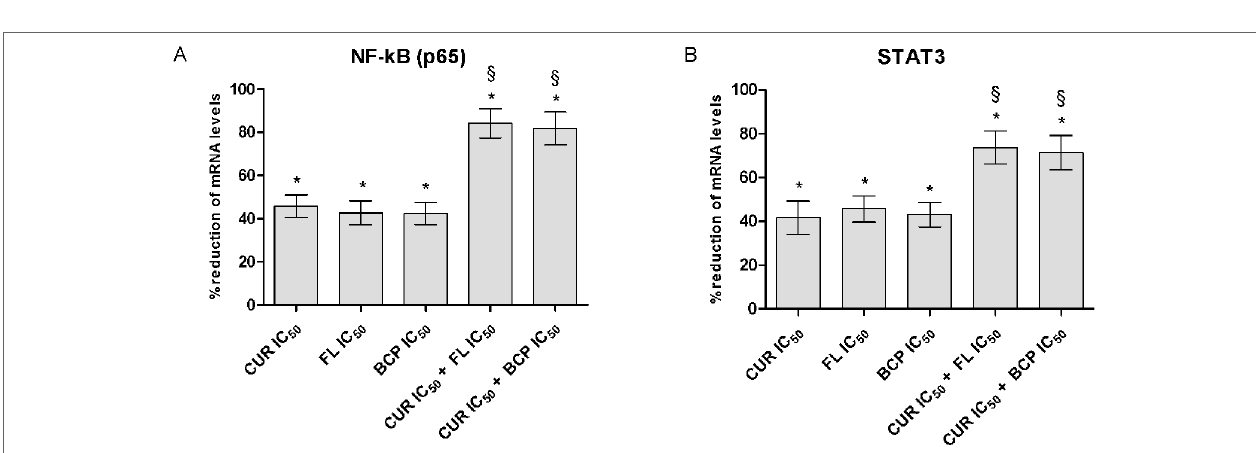
FIgURE 7 | The graph shows cytotoxicity assay at 24 h in control cells (chondrocytes) and in chondrocytes treated with IC 50 doses of flavocoxid, BCP, curcumin and flavocoxid+curcumin and BCP+curcumin. All IC 50 doses were tested in duplicate.